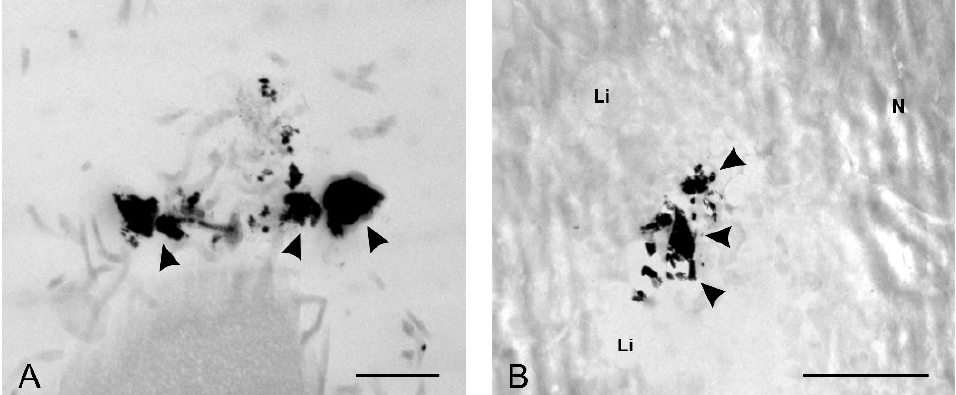
Figure 9. TEM micrographs showing the presence of electron-dense structures (black arrow heads) along the membranes of A375 cells ( A , with bar at 1 µm) and on the surface of HaCaT cells ( B , bar at 2 µm); Li = lysosome, N = nucleus. Molecules 2020 , 25 , x FOR PEER REVIEW